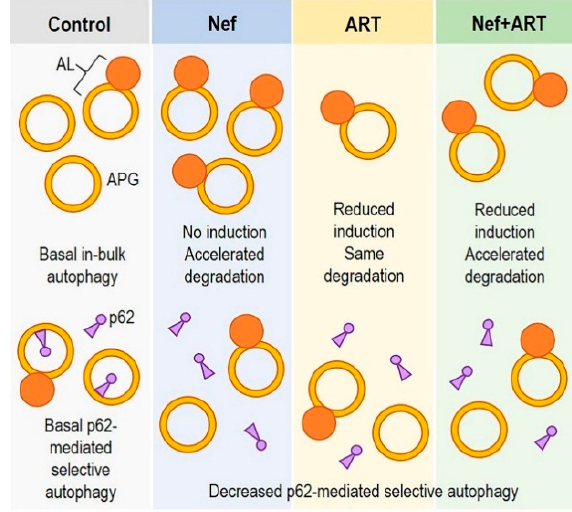
Figure 8. Schematic depicting in-bulk autophagy dysregulation and inhibition of p62-medicated selective autophagy in astrocytes after Nef and/or ART treatment.